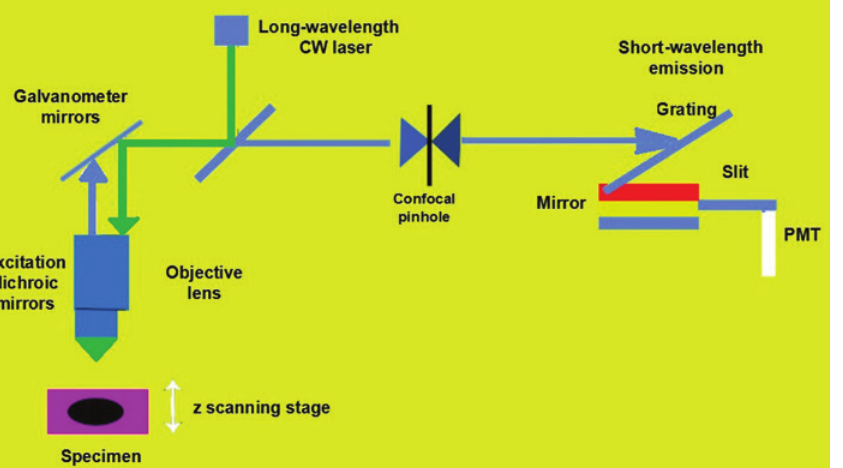
Figure 1: Schematic layout of a LSUCLM system setup; the excitation beam path from a CW laser is shown in green, and the upconversion emission pathway is shown in blue. Reprinted with permission from Ref.